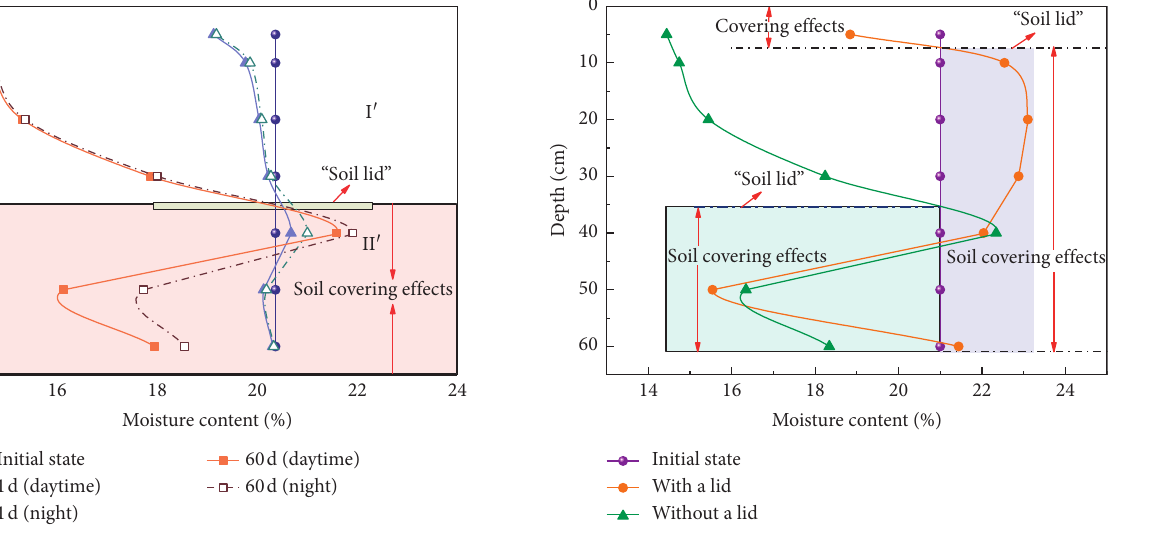
column (without a